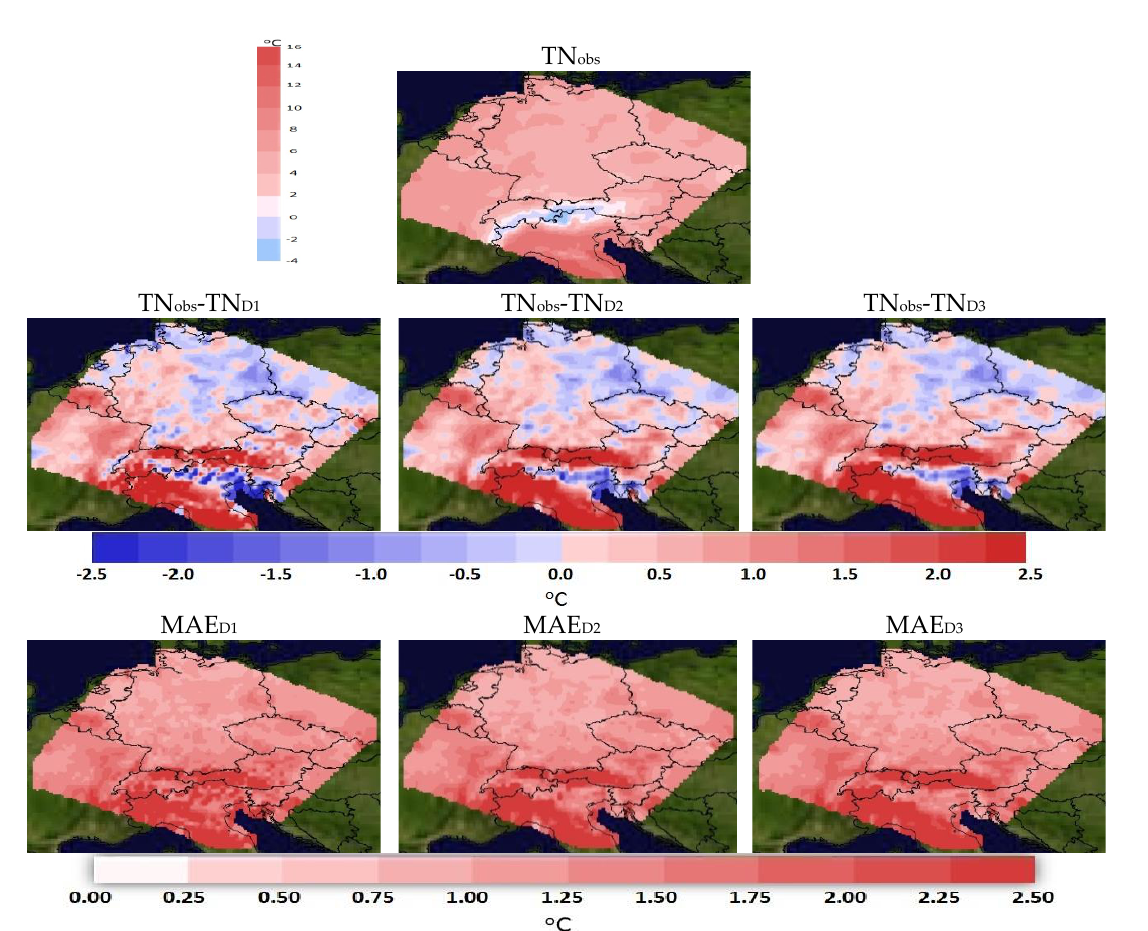
Figure 5. Spatial distribution plots for annual minimum temperature: observed data (upper panel), differences between observed and simulated data for the three nested domains (middle row), and the related MAE (lower row). Table 5. Annual minimum temperature statistical analysis (°C).